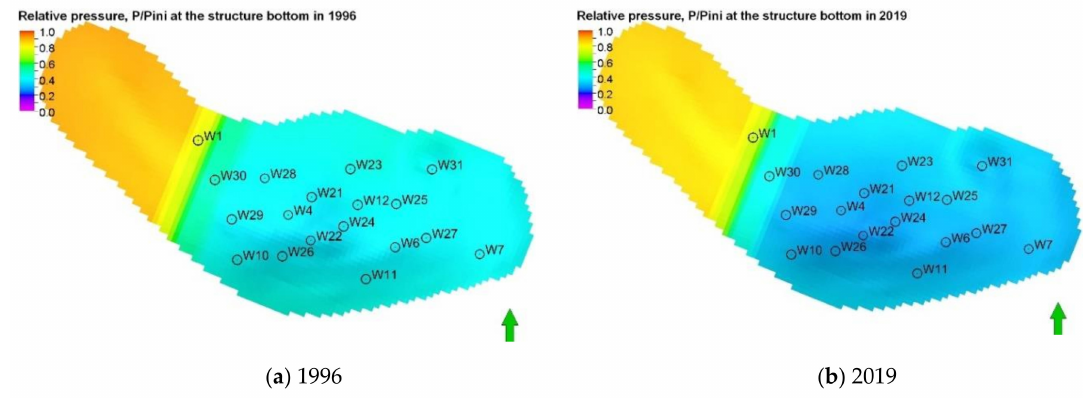
Figure 25. Relative pressure distribution at the structure